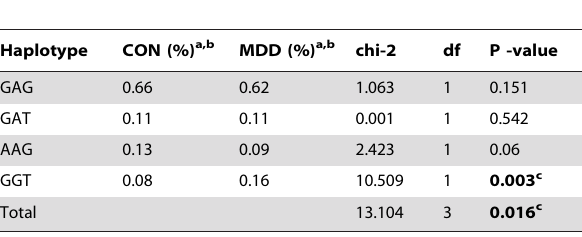
a Haplotype frequencies (%) estimation using the EM algorithm from Arlequin. b All haplotypes estimated to occur with a frequency of at least 1% in MD patients or controls are represented. c Bold numerals p-values after Bonferroni correction.